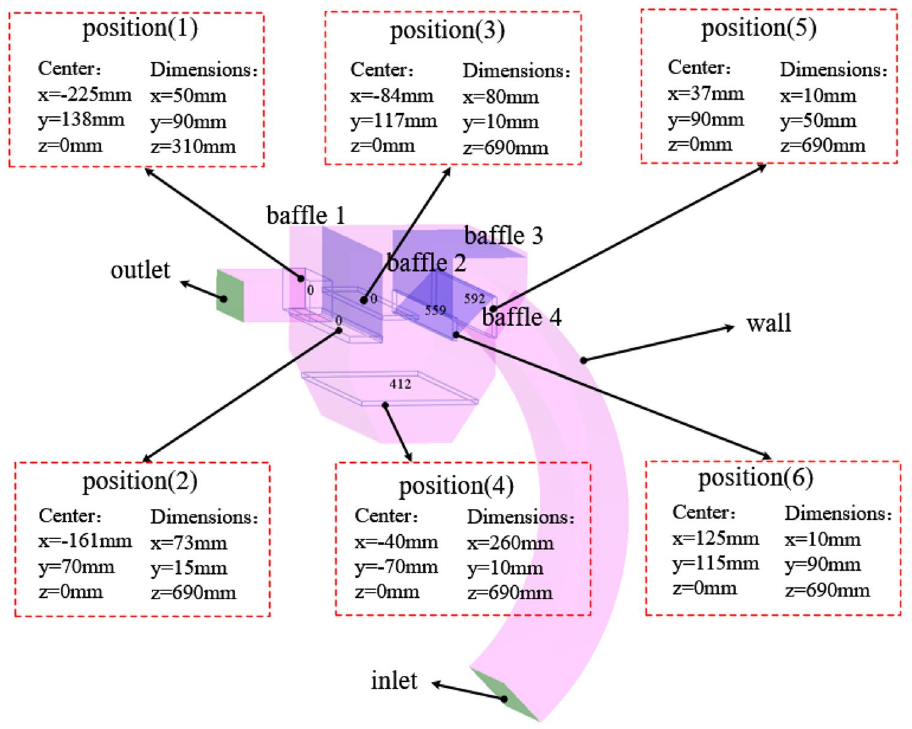
Figure 12. Particle data recording location